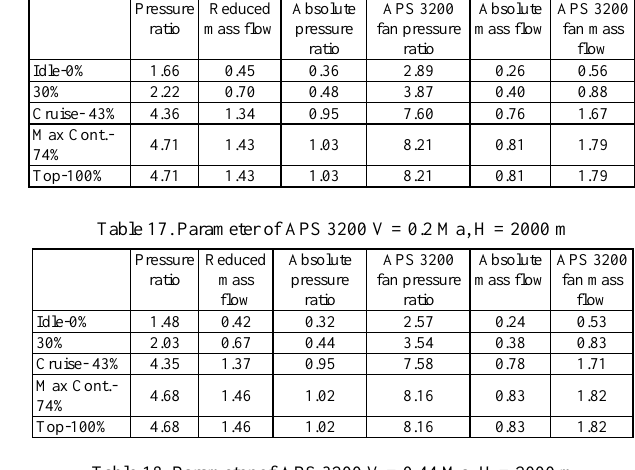
Table 18. Parameter of APS 3200 V = 0.44 Ma, H = 2000 m